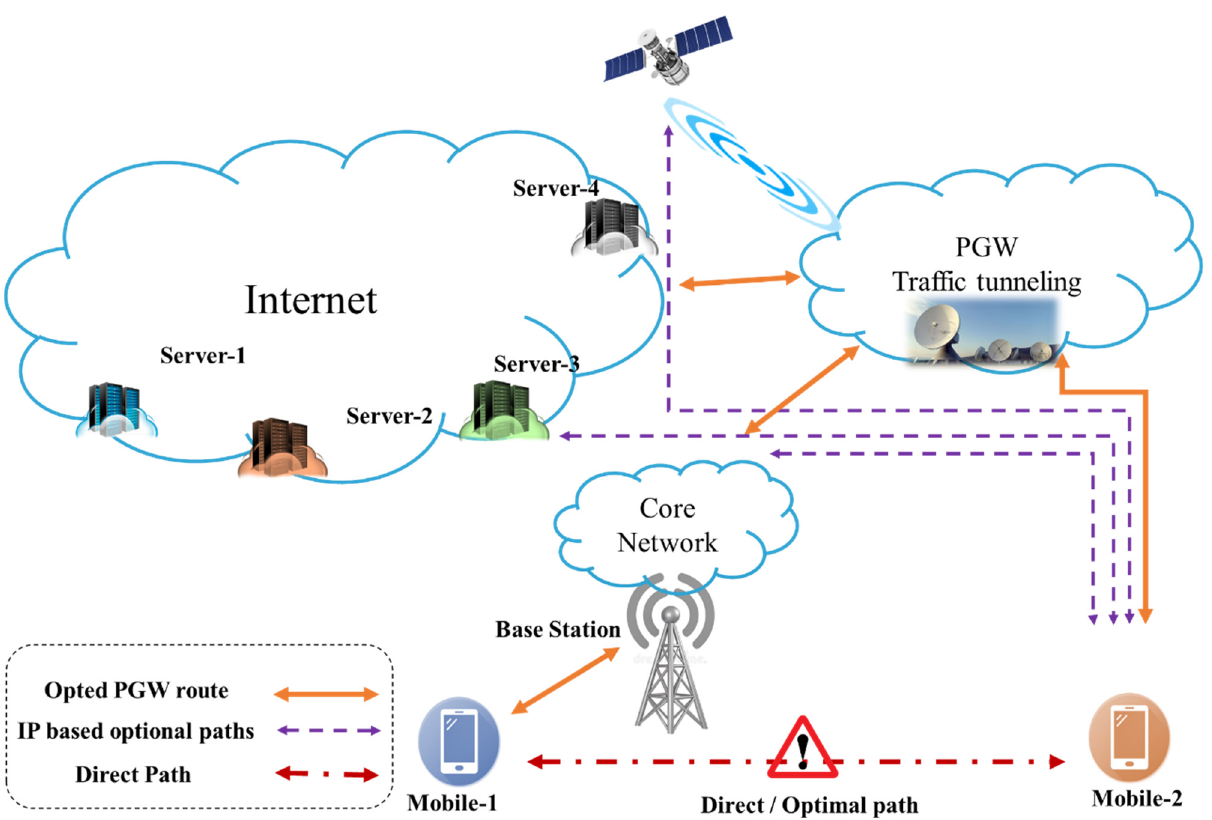
Figure 1. Centralized mobility IP data flow management.